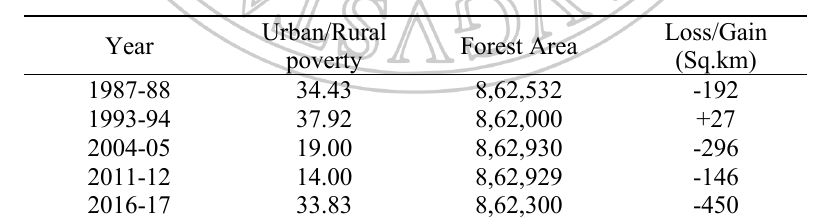
Table 3 : Rural poverty and total forest area